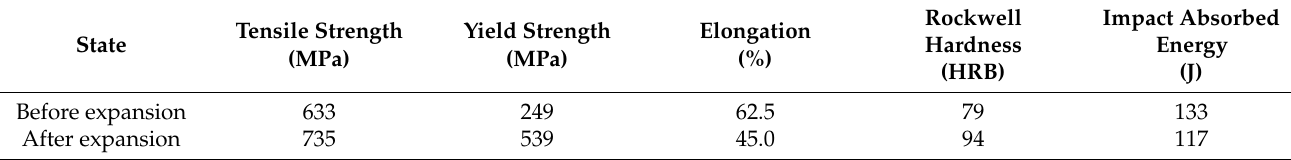
Figure 4. Stress–strain curves of ASIS 304 SS before and after expansion. Table 3. Mechanical properties of AISI 304 SS before and after expansion.